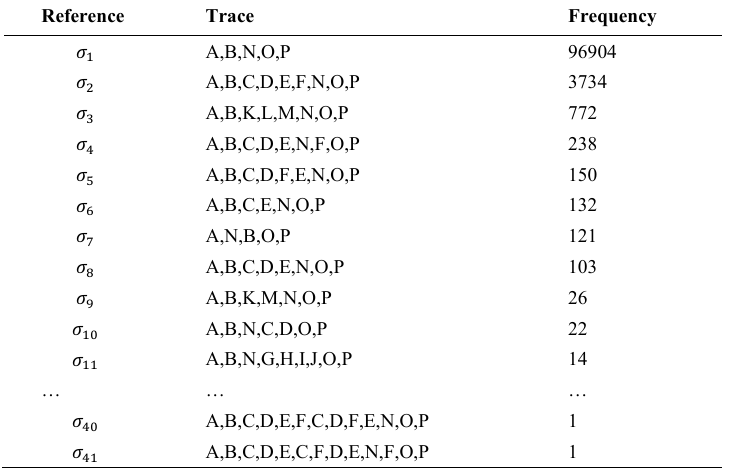
TABLE 2 V ARIANT L ABEL OF T RACES IN THE L OG